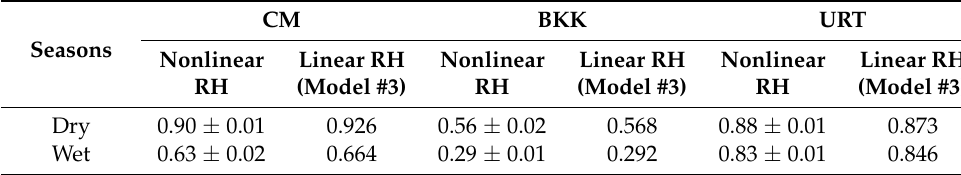
Table 5. Correlation coefficients for linear and nonlinear RH models.